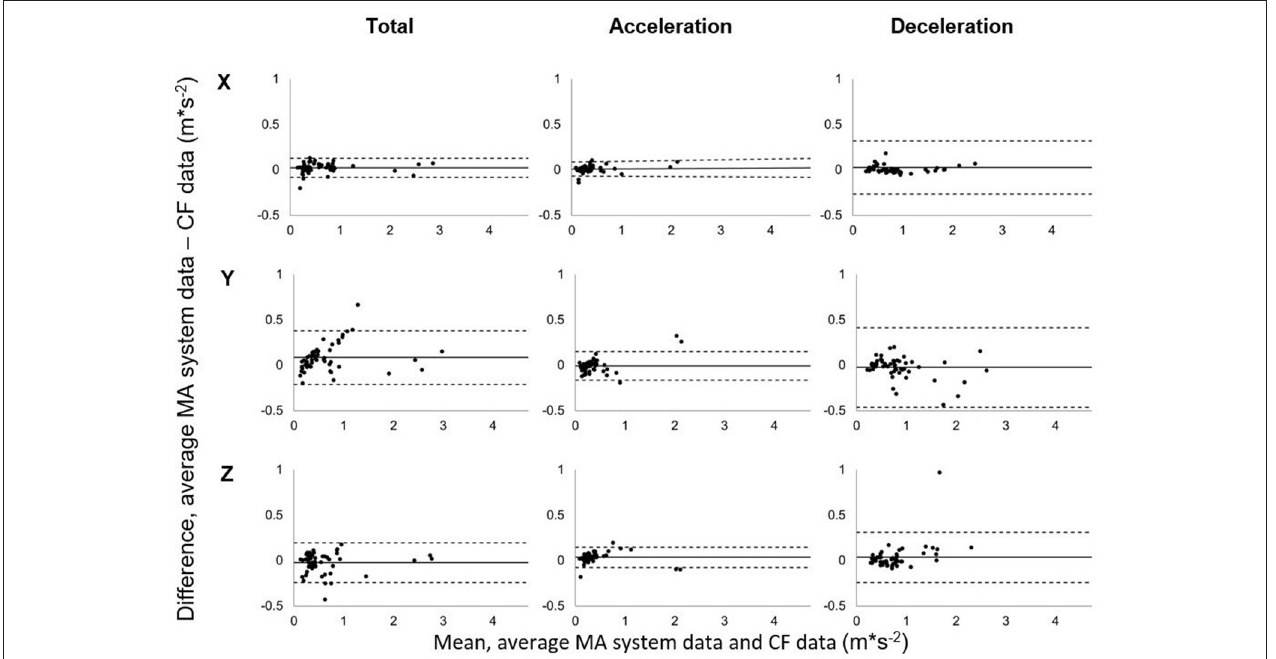
FIGURE 2 | Bland-Altman plots showing the relationship between MA system data and CF data for average total, positive, and negative acceleration in x-, y-, and z-axis each. Dashed lines: 95% LoA, solid line: mean bias.